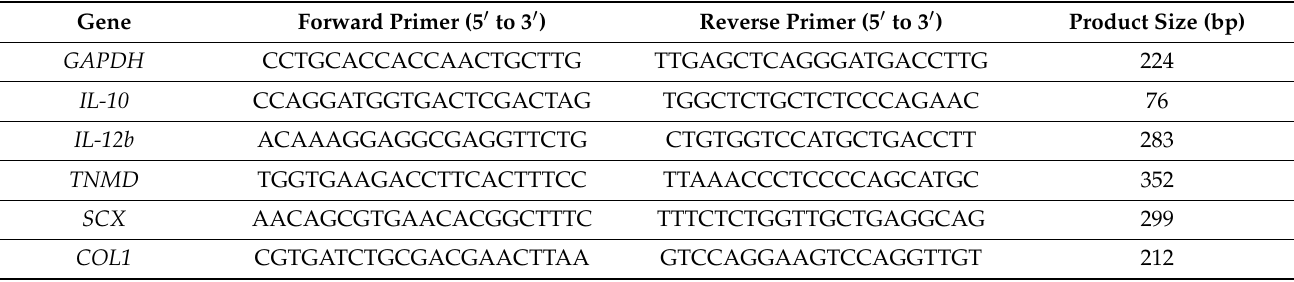
Table 1. Details on primer